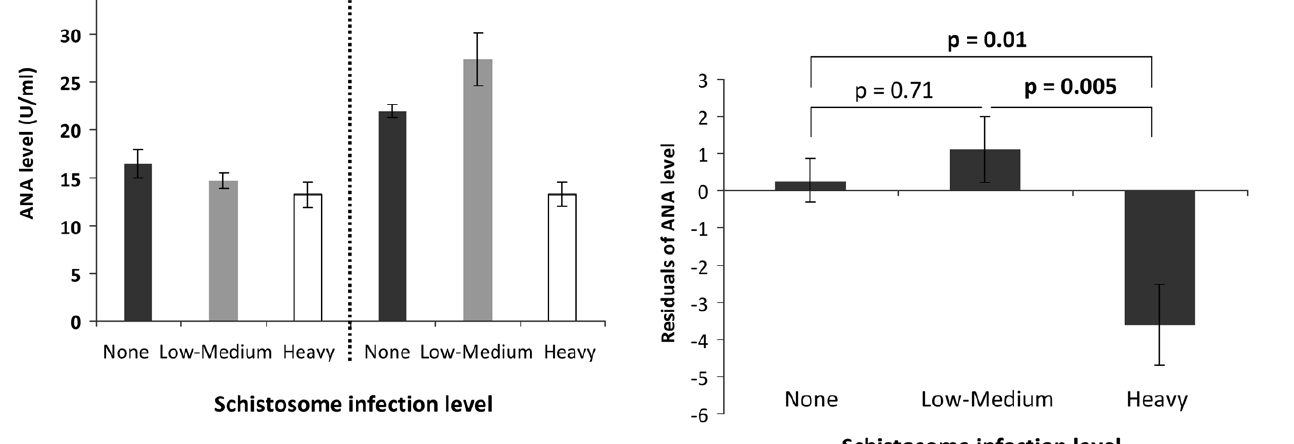
Figure 2. Levels of anti-nuclear antibody (ANA) levels in the different infection groups in the study villages. Bars represent individuals carrying no infection in black, low-mild infection intensity (1–49 eggs/10 ml urine) in grey and high infection intensity (50 + eggs/ 10 ml urine) in white. S. haematobium infection intensity was quantified by urine filtration. Error bars represent standard error of the mean.